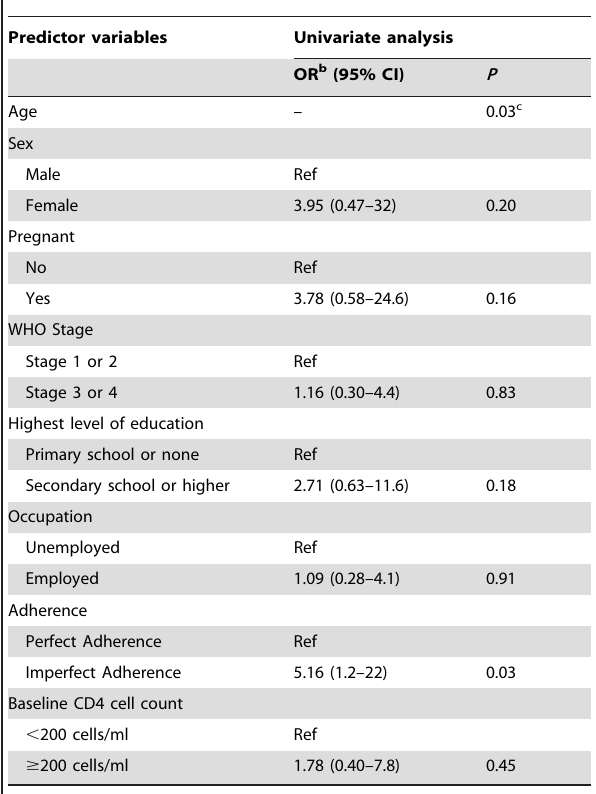
Table 3. Characteristics associated with HIV RNA PCR virologic failure for antiretroviral naı¨ve patients receiving antiretroviral therapy (ART), Mombasa, Kenya.